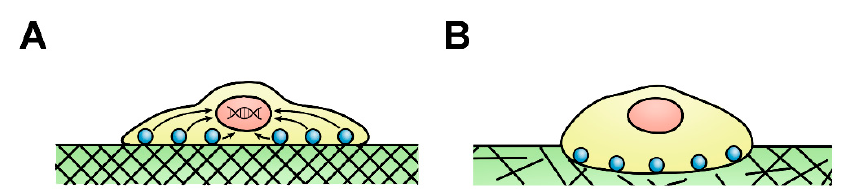
Figure 2. Variations in substrate stiffness between healthy and emphysematous cells. ( A ) Fibroblast seeded on a comparatively stiff healthy lung extracellular matrix (ECM). Substrate stiffness stimulates cell surface proteins to produce a signalling cascade (mechanotransduction) resulting in gene expression. The healthy lung is considered a pliable, low-stiffness organ yet is stiffer in comparison to the emphysematous lung. ( B ) Fibroblast seeded on a soft, emphysematous ECM. ECM scaffolding proteins remain present in the emphysematous lung ECM but are disorganised while cell surface proteins cannot initiate the signalling cascade without mechanical stimulation.